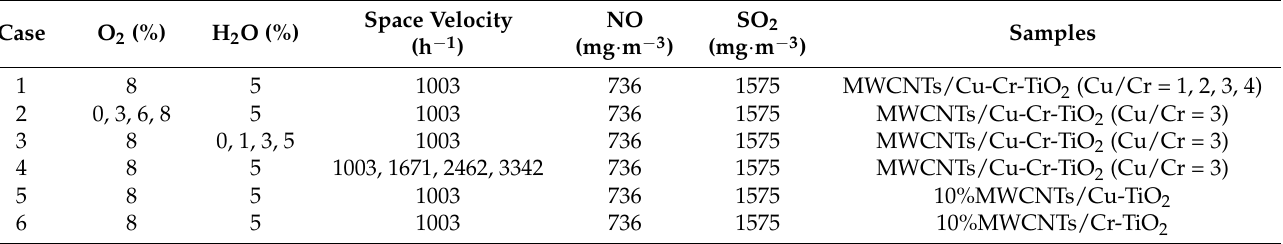
Table 1. Different experiments in this